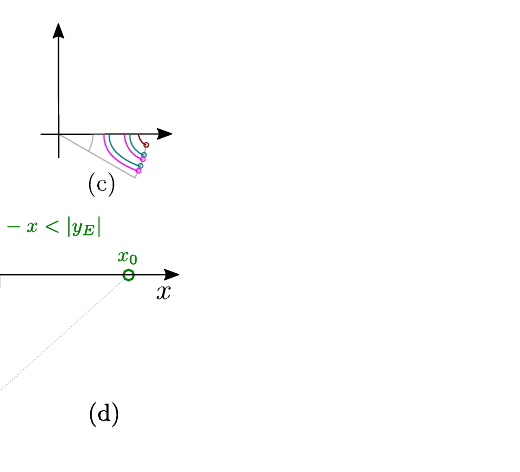
Figure 7. Circular barrier construction. Subfigures ( a )–( d ) are explained within the Sections